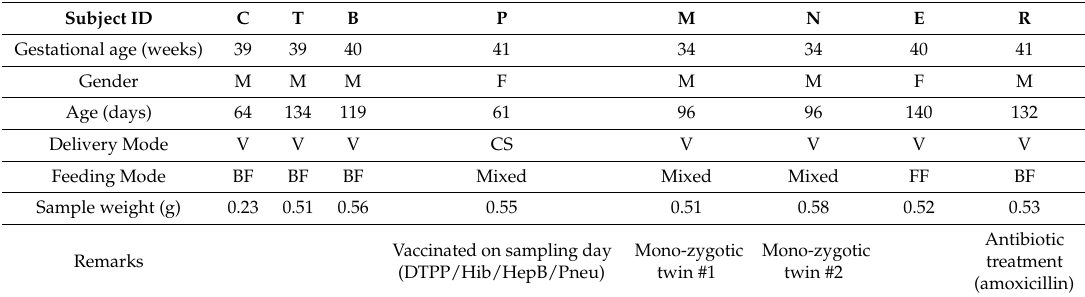
Table 3. Infant fecal sample